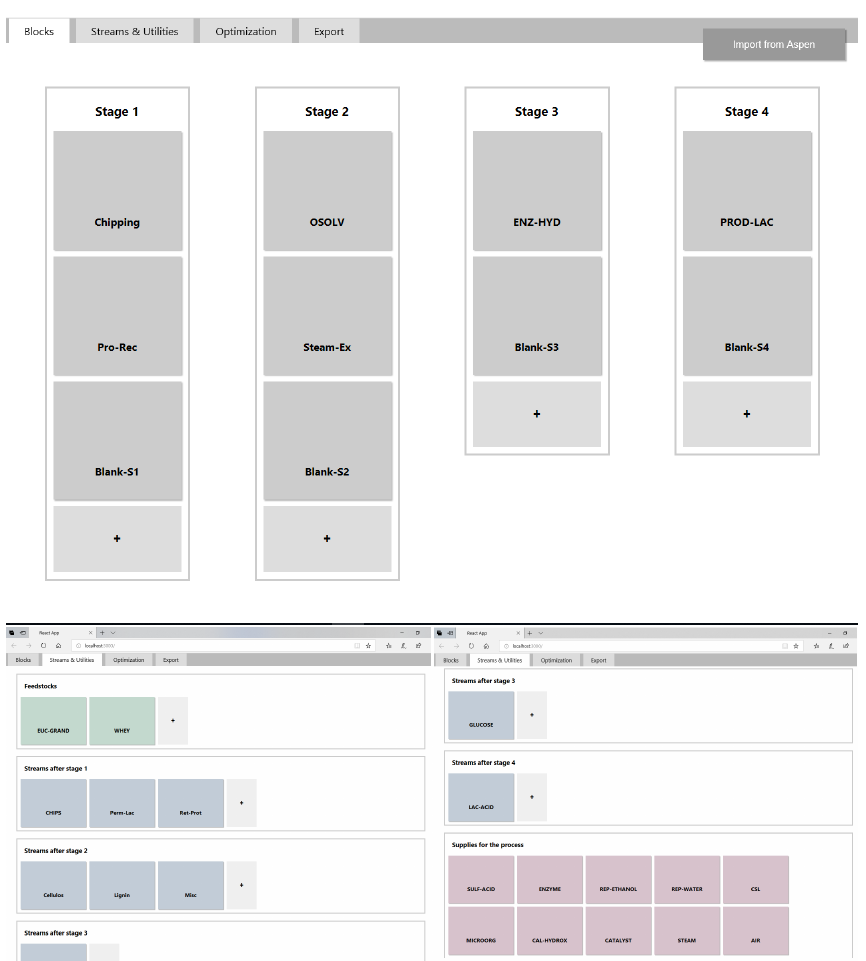
Figure 6. Screenshot of the implementation of the superstructure in Figure 5 in BISSO. Top: Blocks tab; Bottom: Stream and Utilities